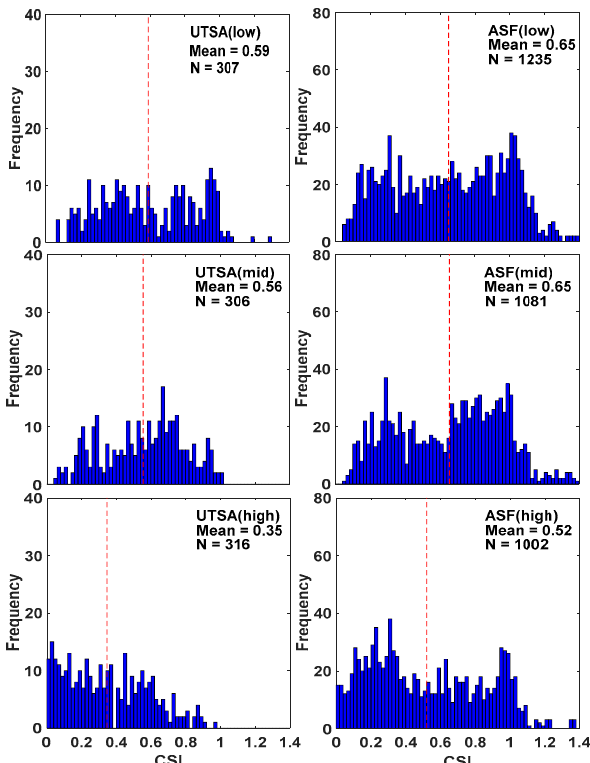
Figure 5. Same as Figure 4 but for individual cloud layers.